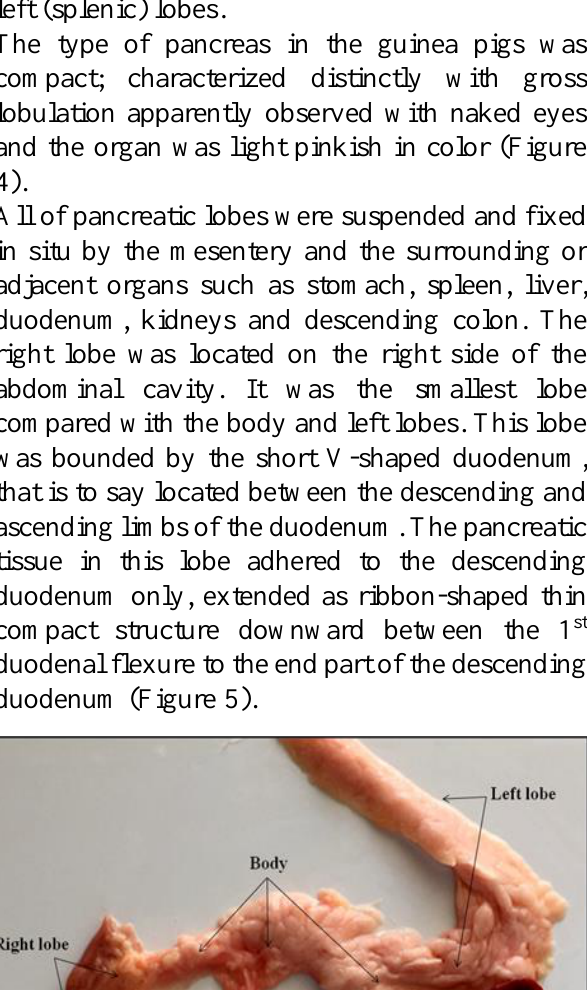
Figure 5. Right lobe closely adherent to the descending duodenum. Connecting part between the body and ascending duodenum (blue star) with adjacent portal vein (white arrow). The figure showed 1 st (1) and 2 nd (2) duodenal flexures.